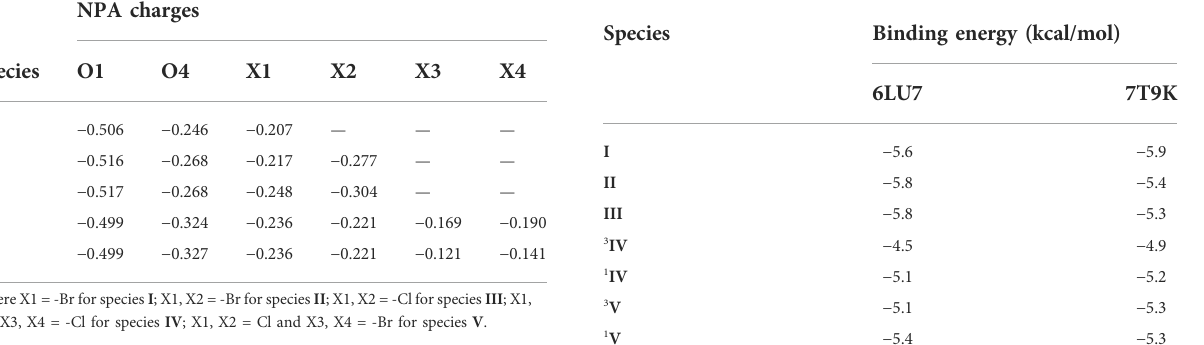
TABLE 3 Computed NPA charges of all the reported species.